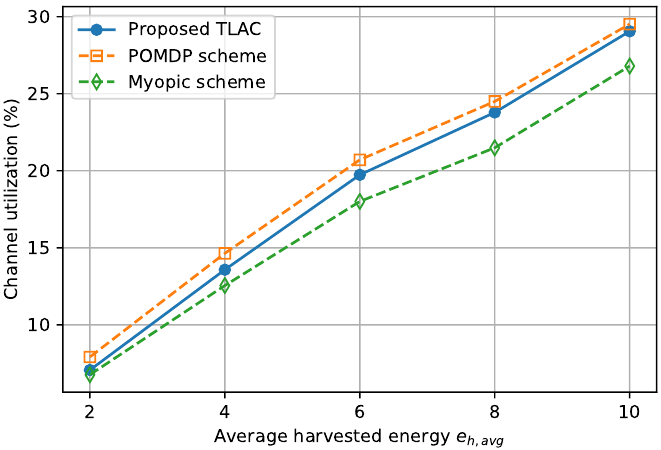
Figure 15. Channel utilization according to the harvested energy for different data protection schemes.